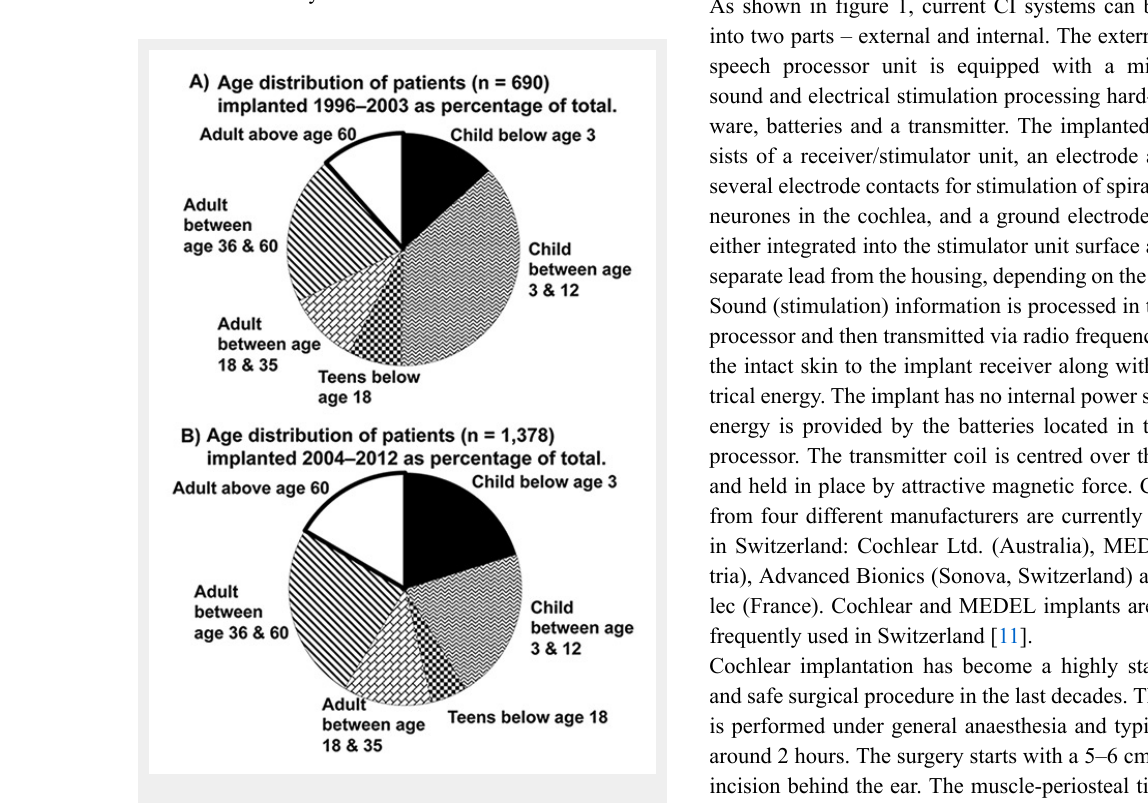
(A) Patients implanted in Switzerland 1999–2003 and (B) Patients implanted in Switzerland 2004–2012, divided into age groups